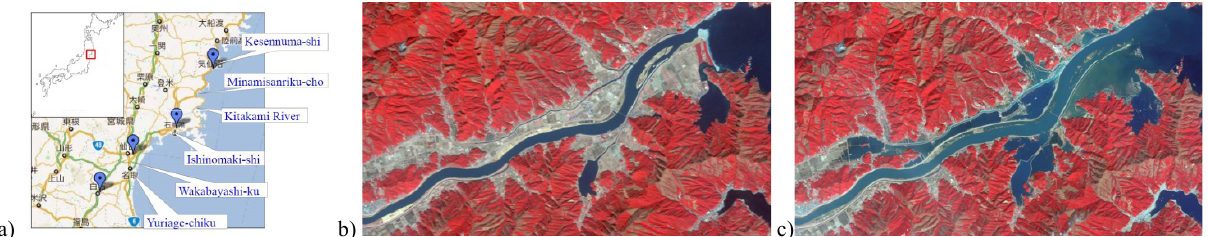
Figure 7. Test sites in Japan (a). ALOS/AVNIR2 false colour images on February 27, 2011 (b) and on March 14, 2011